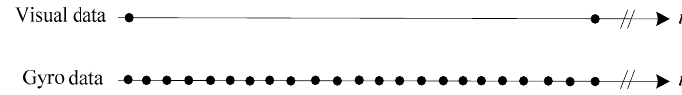
Figure 1. Sampling frequency discrepancy between visual and inertial data.